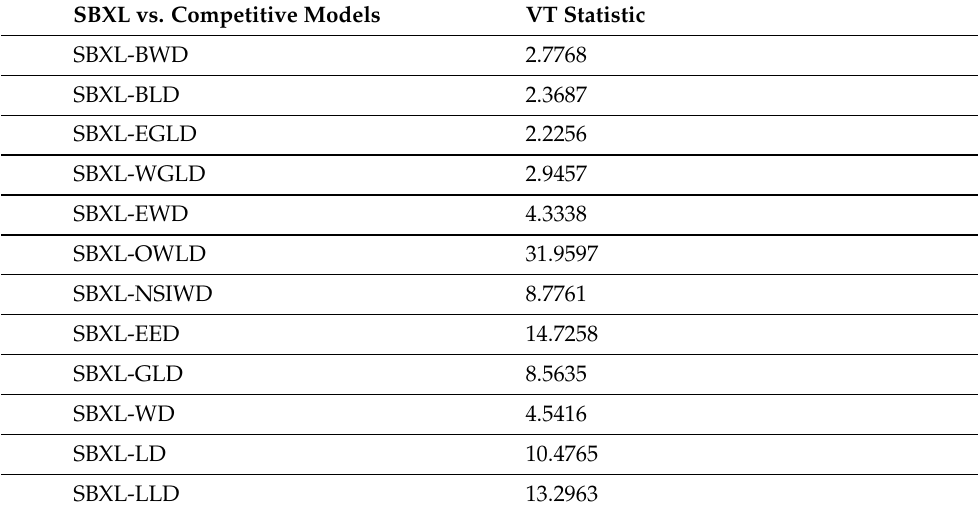
Table 14. Vuong’s test (VT) applied on data set II at Z 0.05 = 1.6495. SBXL vs. Competitive Models